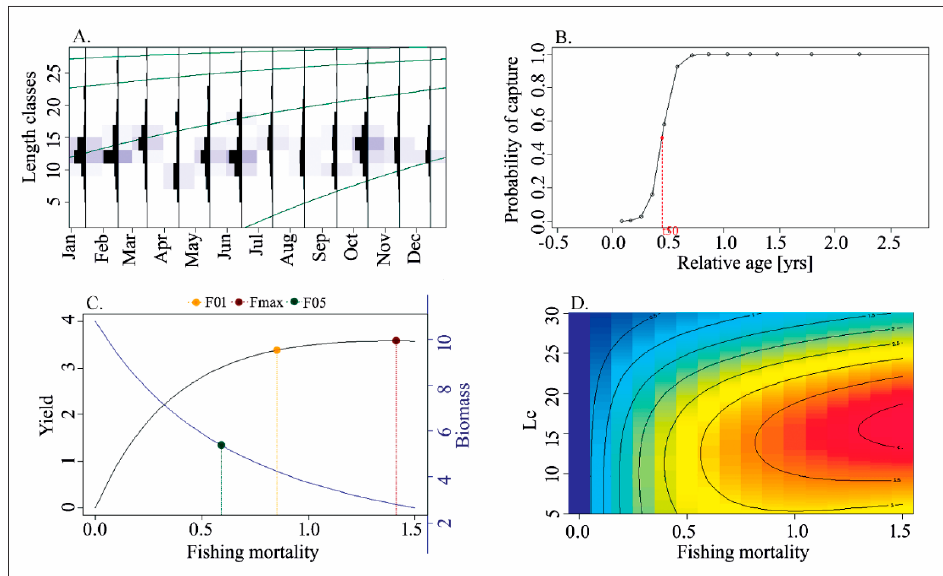
Figure 6. The outputs of ‘TropFishR’ showing: ( A ) the von Bertalanffy growth curve and length- frequency distribution of the Bombay duck ( L ∞ = 30.47 cm, K = 0.86 year − 1 ); ( B ) linearized length- converted catch curve to estimate total mortality ( Z = 3.06) and the selectivity function of the catch curve estimated as length at first capture ( L c ) of 9.69 cm; ( C ) yield and biomass per recruit analysis when L c = 9.69 cm—the green, yellow and red dashed lines represent F 0.5 = 0.59 year − 1 , F ma x = 1.41 year − 1 , and F 0.1 = 0.85 year − 1 , respectively; ( D ) relative YPR in response to different fishing mortality and different length at first capture ( L c ).